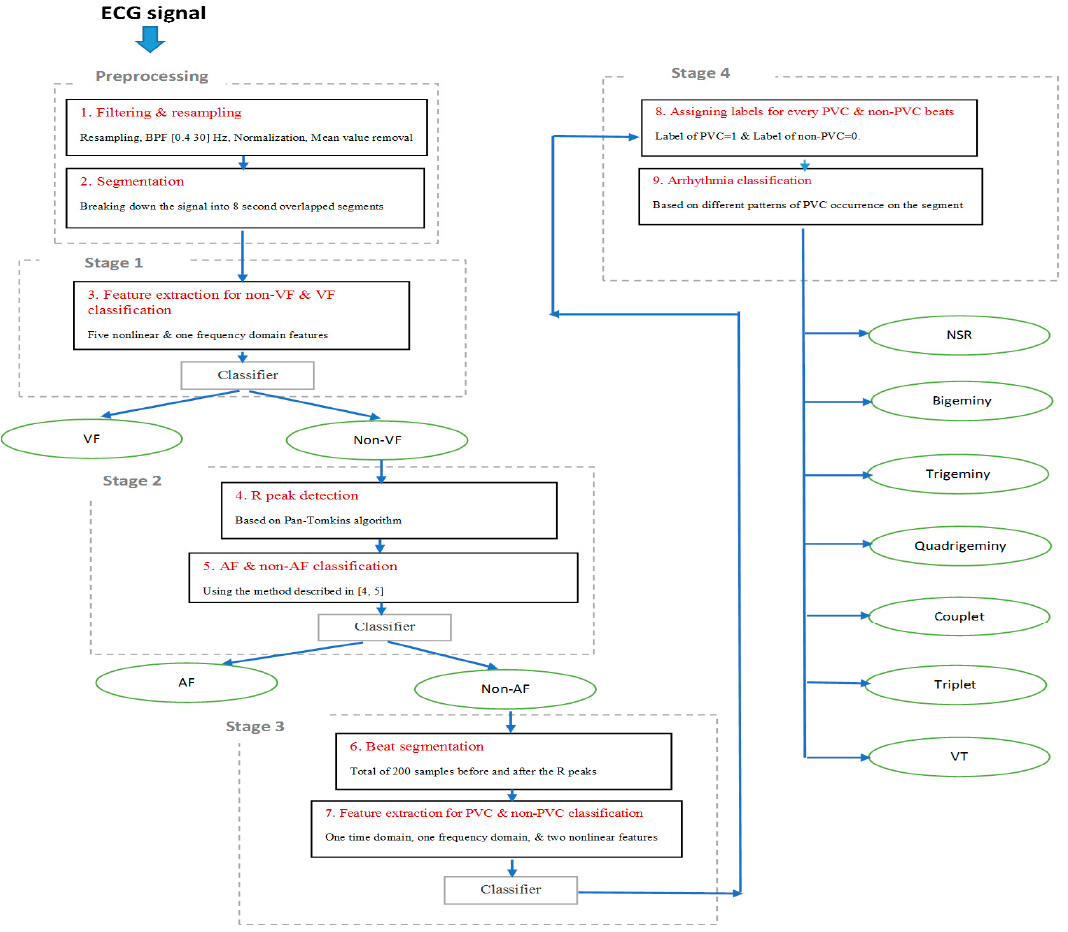
Figure 2. Our overall process.